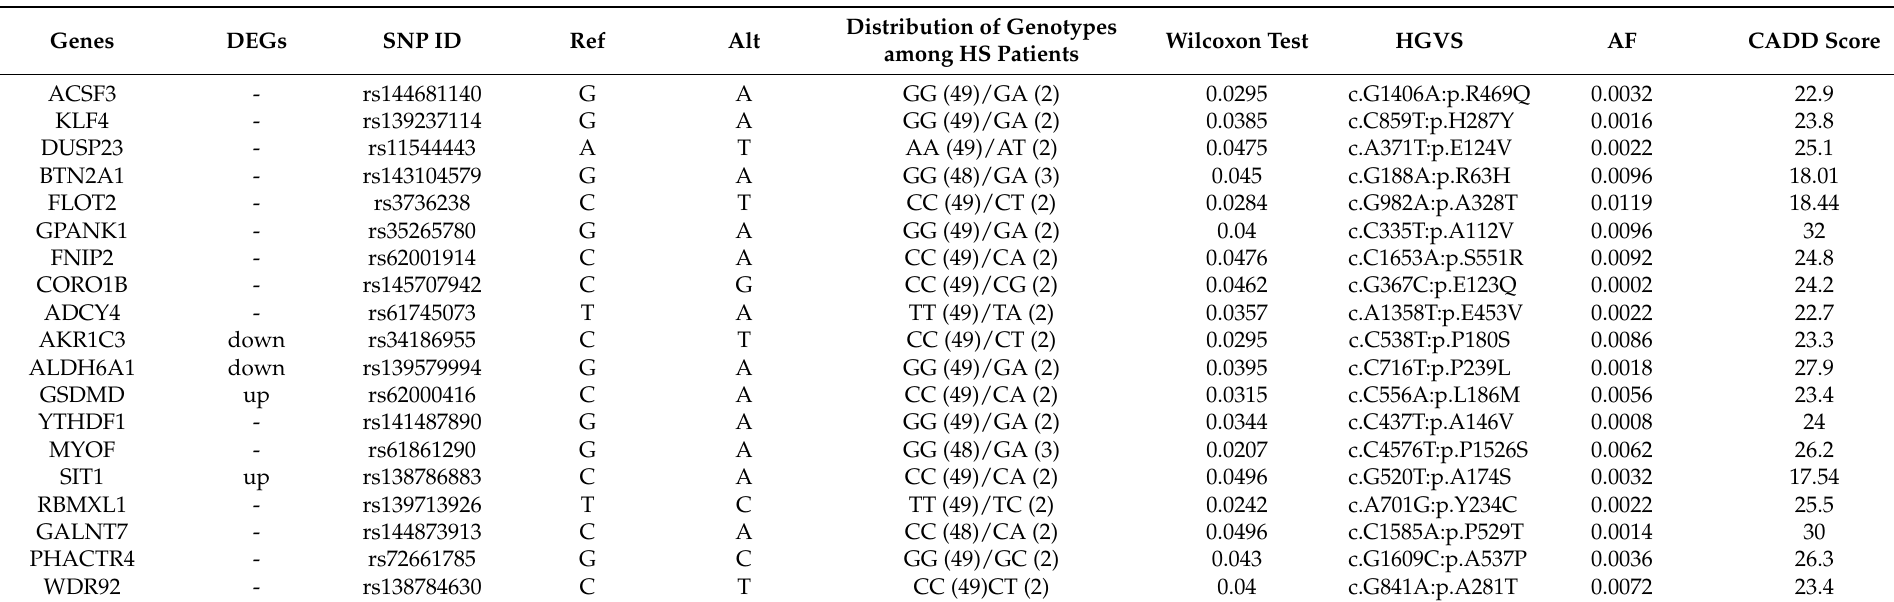
Table 4. Potential Clin Var pathogenic non-synonymous variants found by the RNA-Seq variant calling analysis in HS patients with an allele frequency ≤ 0.01, CADD score > 15, and genotypic differences that were statistically significant ( p value <